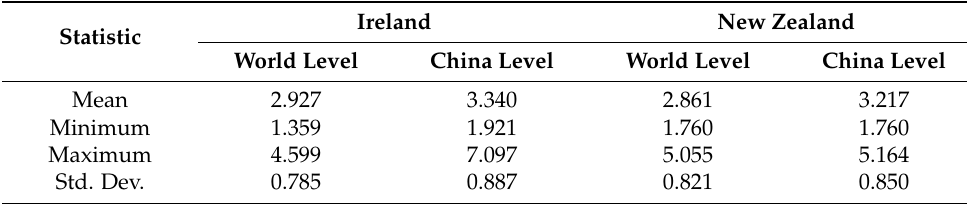
Table 1. Descriptive statistics for the export prices of Ireland and New